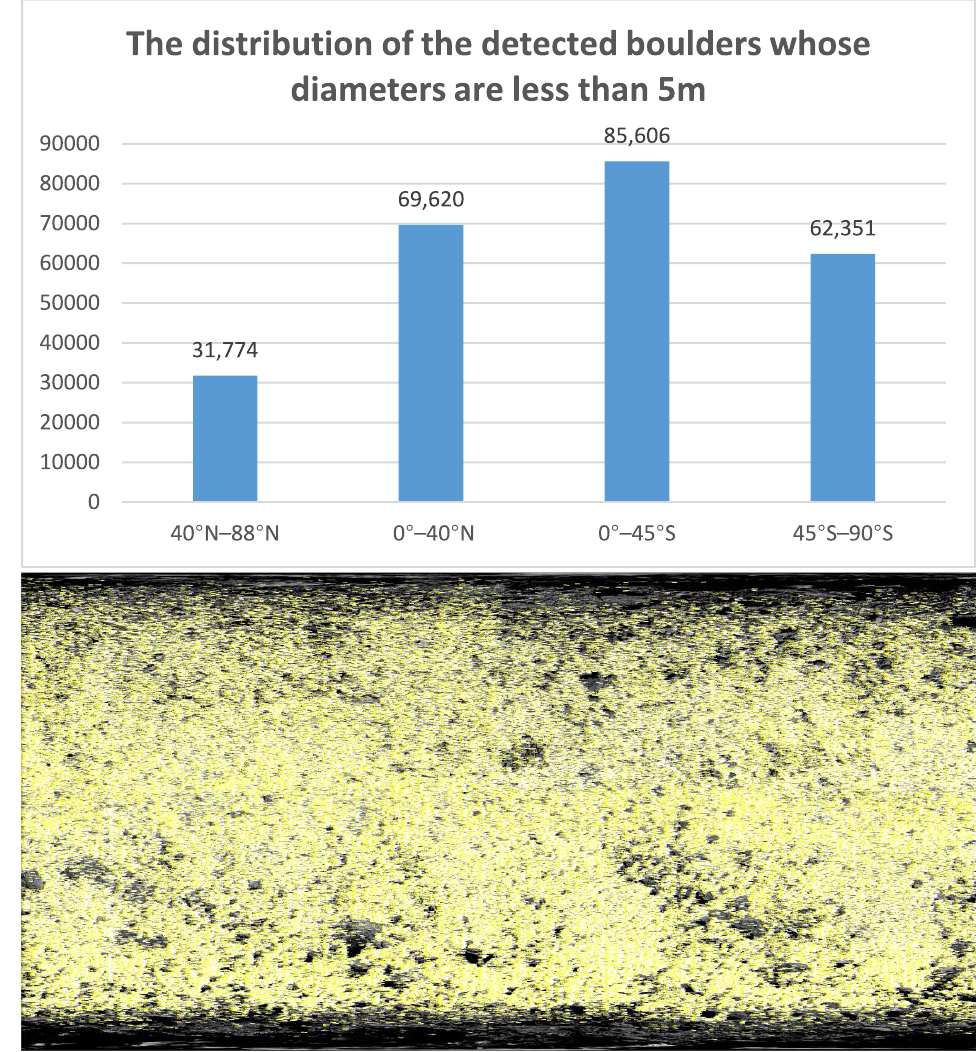
Figure 7. The distribution of the detected boulders whose diameters are less than 5 m in each region. Figure 8 shows the distribution of boulders whose diameters are between 5 m and 10 m in each region on the surface of the Bennu asteroid. For the numbers shown in the subfigure in the up of Figure 8, it can be seen that there are 4082 detected boulders whose diameters are between 5 m and 10 m at the poles, i.e., the regions of 40°N–88°N and 45°S–90°S, accounting for about 59% of the total number. This shows that more boulders of this kind are located at the poles. It can be also seen from that shown in the subfigure below Figure